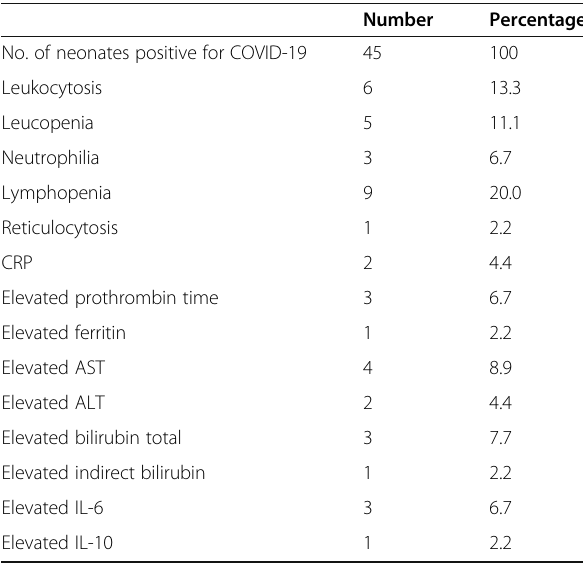
Table 5 Laboratory abnormalities in